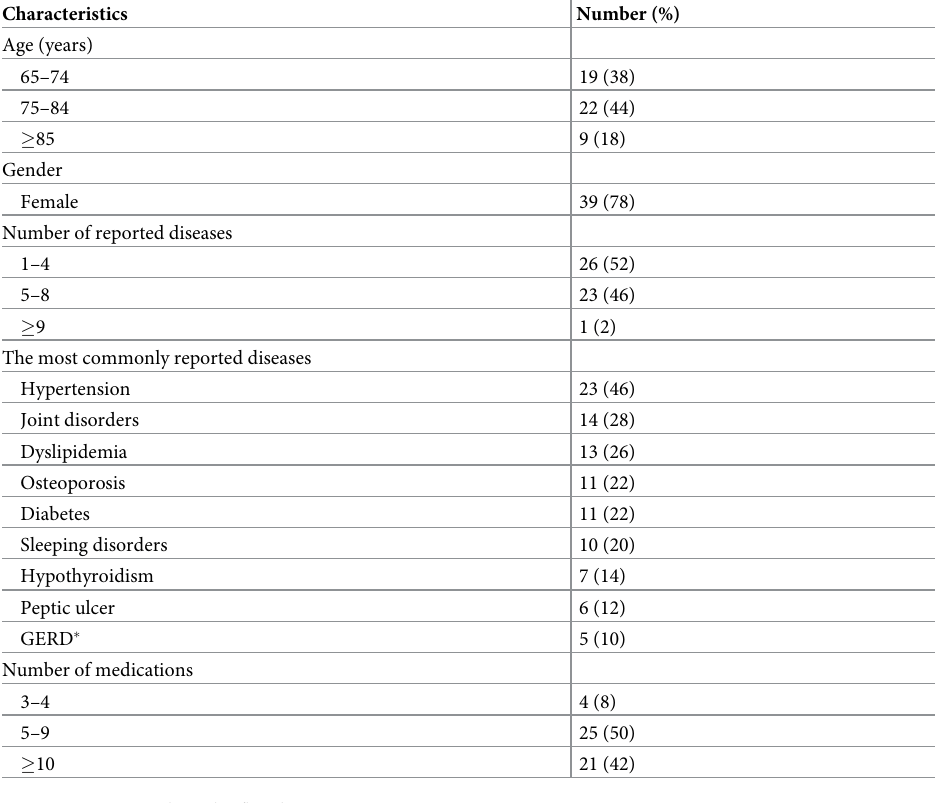
Table 1. Demographic and clinical characteristics of